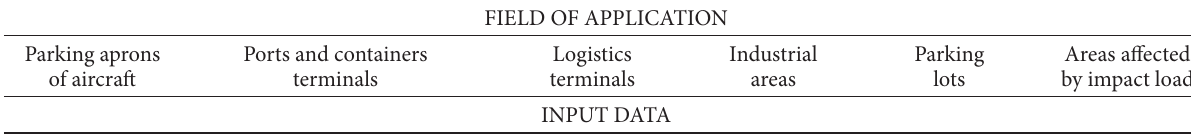
table 2. Flow chart of pavement structure design